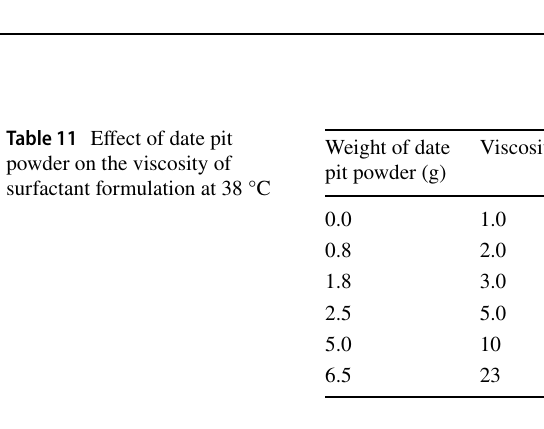
Table 10 The categories of available cEOR technologies (Raffa et al. 2016)